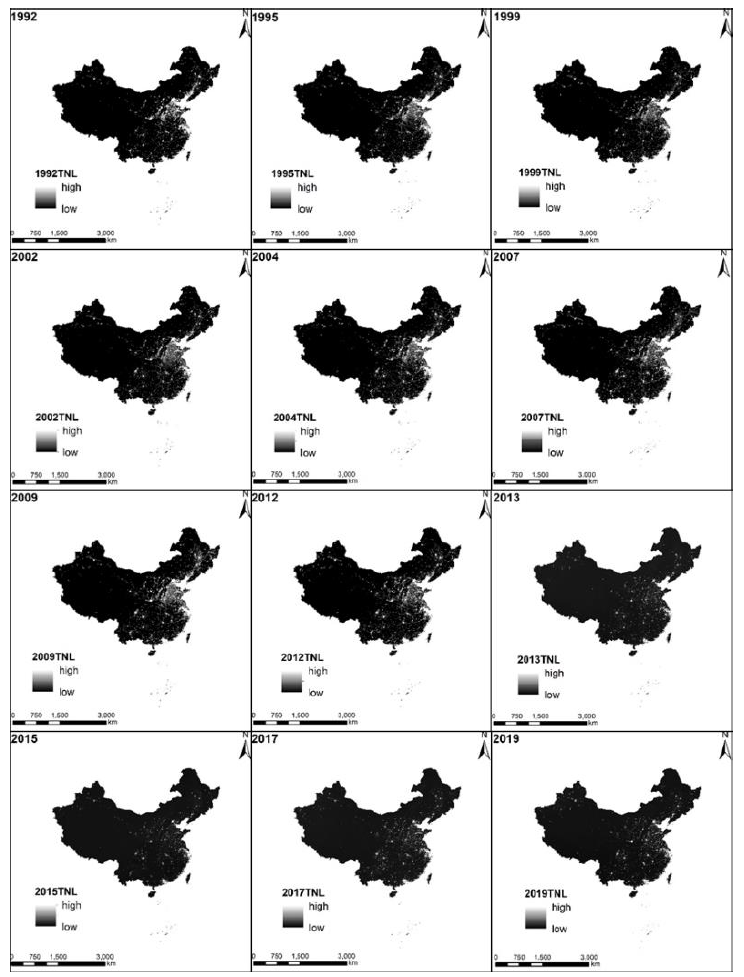
Figure 5. The calibrated NTL remote sensing images in China from 1992 to 2019.